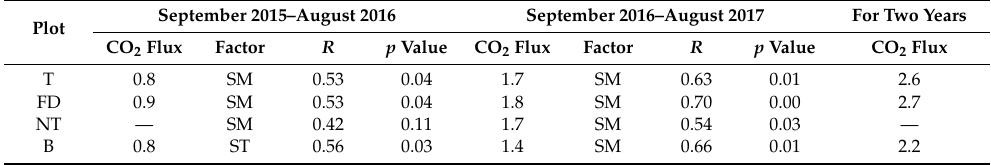
Table 3. Estimated annual CO 2 flux in each treatment plot in each experimental